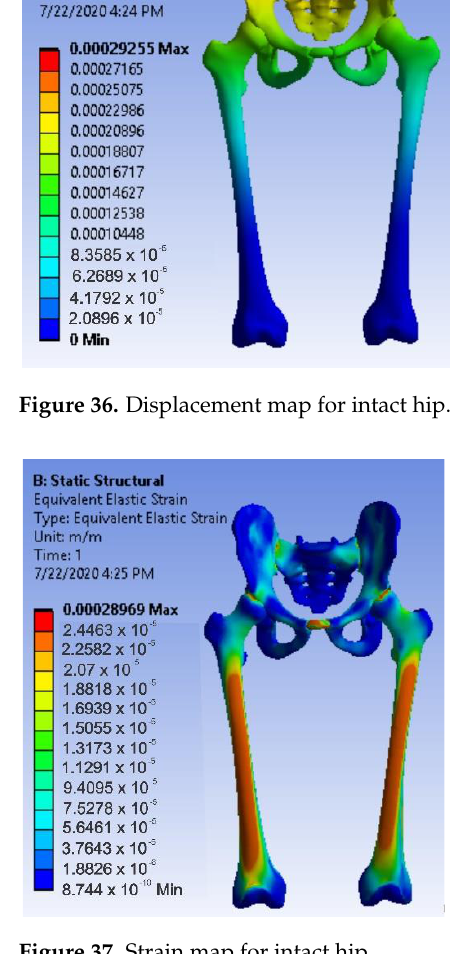
Figure 37. Strain map for intact hip.